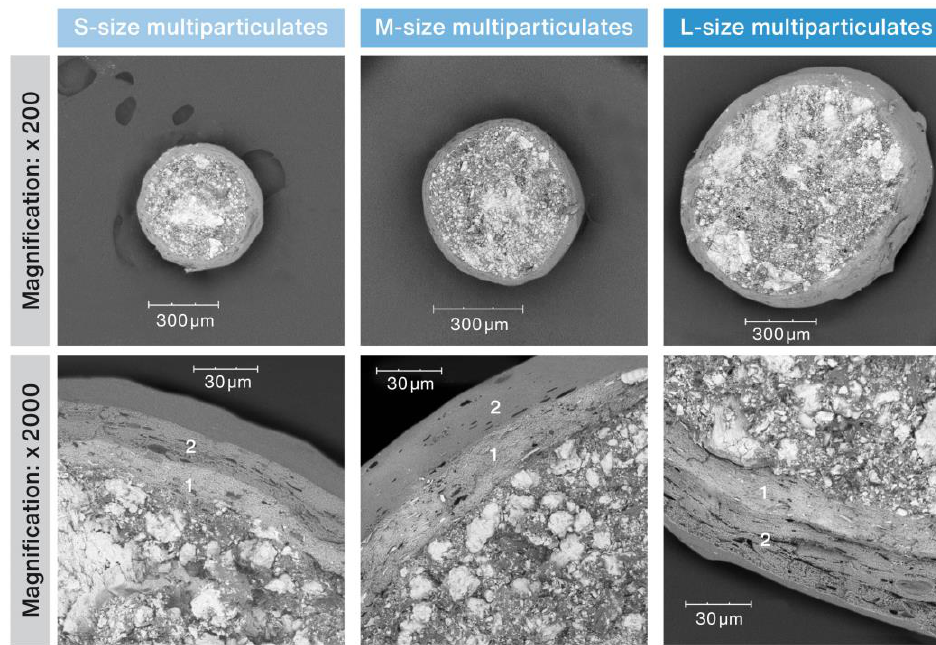
Figure 1. SEM micrographs of cross-sections of RSC multiparticulates (magnification of 200× and 2000×).